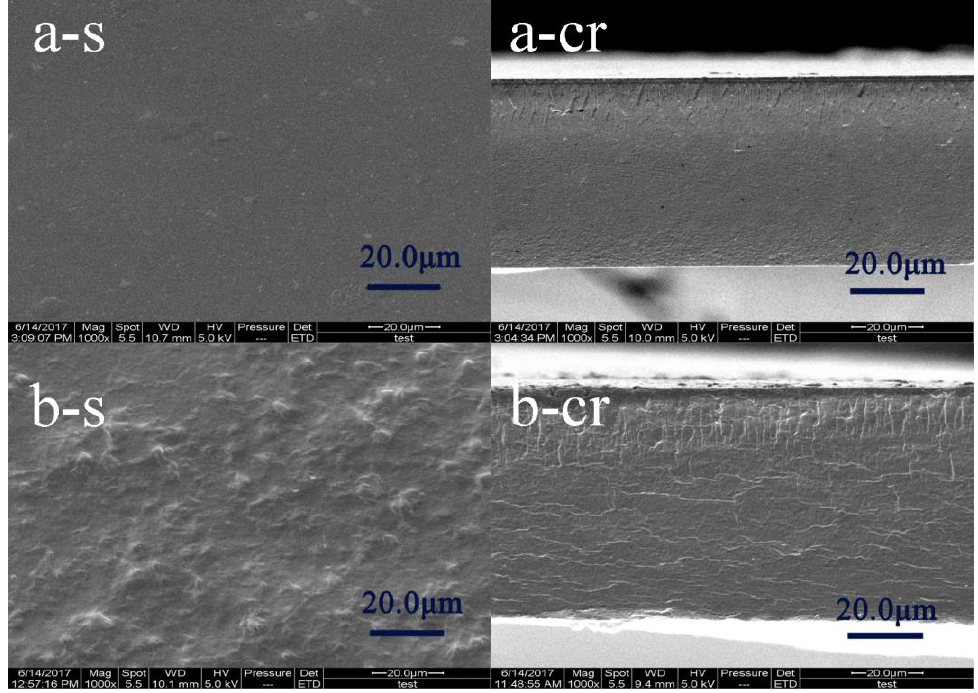
Figure 3. Scanning electron microscopy (SEM) micrographs of the surface (s, left ) and cross-section (cr, right ) of the ( a ) SPI and ( b ) SPI/CPE films.